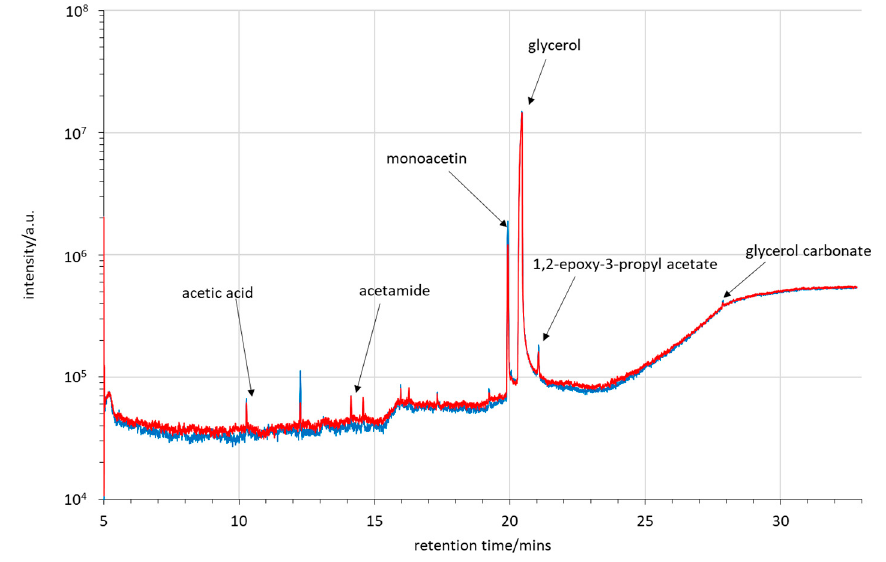
Figure 4. Gas chromatography–mass spectrometry (GC–MS) spectra of reaction products in the absence of catalyst. Two repeats are shown. Note that diacetin (retention time 19 min) and triacetin